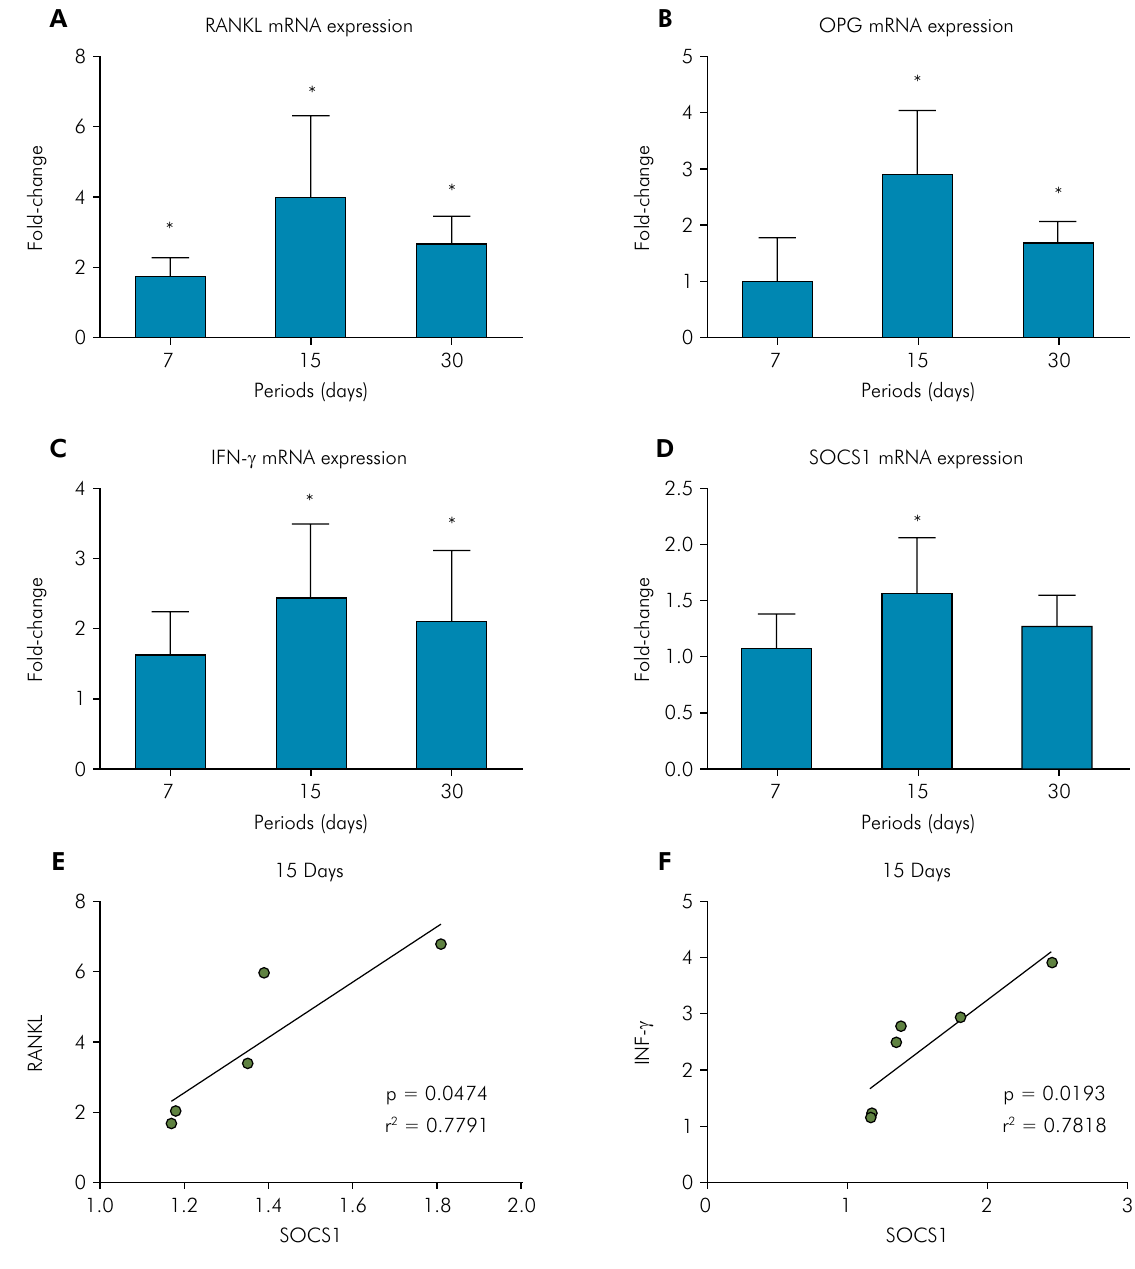
Figure 3. Expression of SOCS1 (E), RANKL (A), OPG (B), and INF- γ (C) mRNA during the course of LPS-induced periodontitis was increased after 7, 15, and 30 days of LPS exposure, peaking at 15 days. The bars represent the mean fold change in comparison to the untreated control, and the vertical lines denote the standard deviation. There were significant positive correlations (p < 0.05) between SOCS1 and RANKL mRNA expression (E) and between SOCS1 and IFN- γ mRNA expression (F).